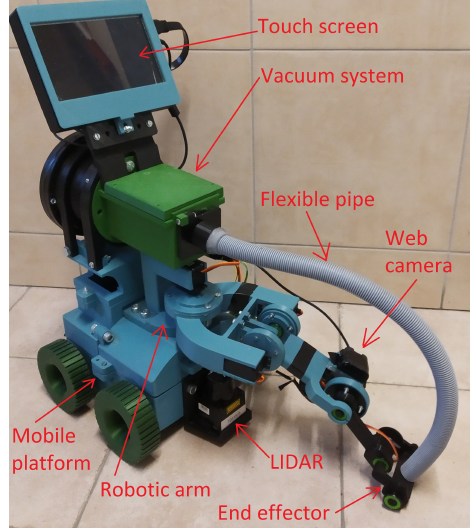
Figure 1. Cleaning